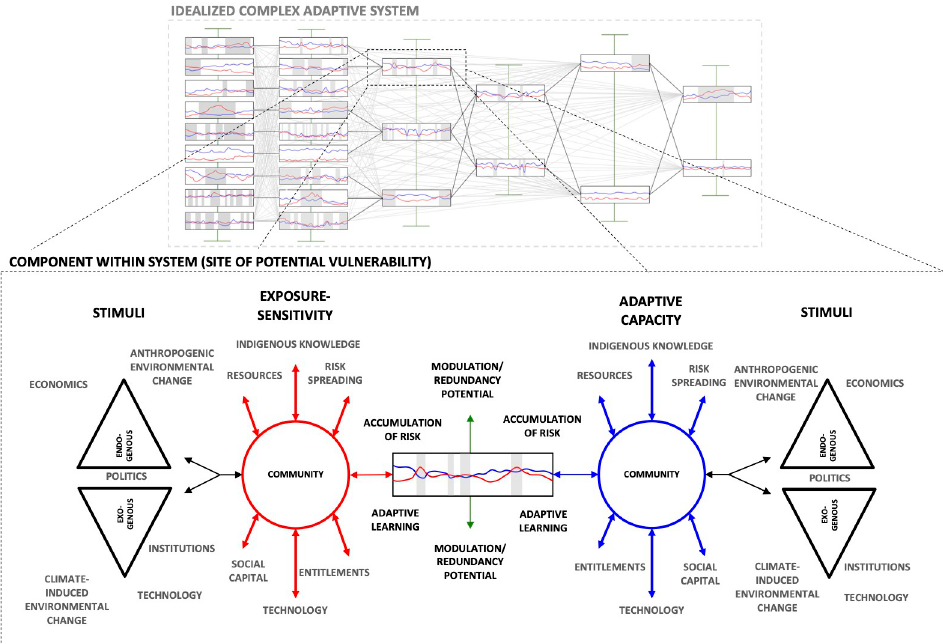
Fig 1. Idealized complex adaptive system, disaggregated into components according to their function. Here, potential vulnerability in each component of the food system (e.g. the availability of certain subsistence species, ability to access lands)—indicated by the box insert—is determined by the role of exogenous and endogenous stimuli and stressors, such as environmental change, the degree to which an individual has access to technology, or their access to entitlements. The ways in which these stimuli interact creates potential exposure-sensitivity (red) and adaptive capacity (blue) across time. The central ‘barcode’ illustrates this interaction and its dynamism, with the grey bars highlighting periods of adaptive deficit (vulnerability). Interconnectedness between components within the system allows vulnerability in a single component to affect or migrate to multiple other areas of the system through time, and to produce emergent/system wide changes (modified from Naylor et al .